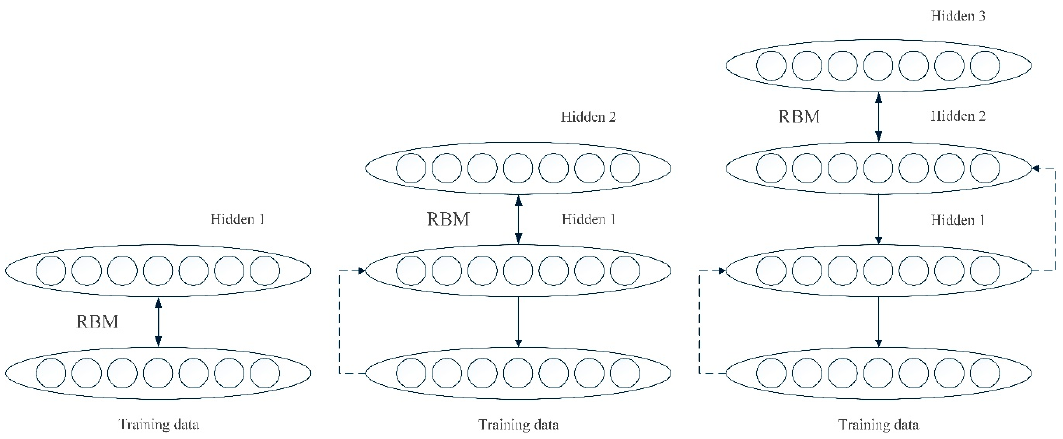
Figure 3. The Algorithm schematic of a restricted Boltzmann machine (RBM).